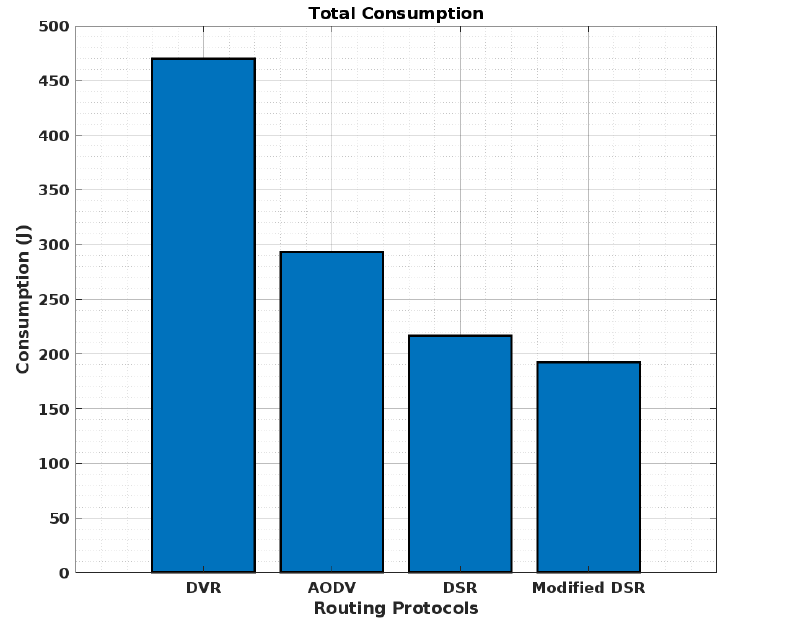
Figure 8. Total average consumption per